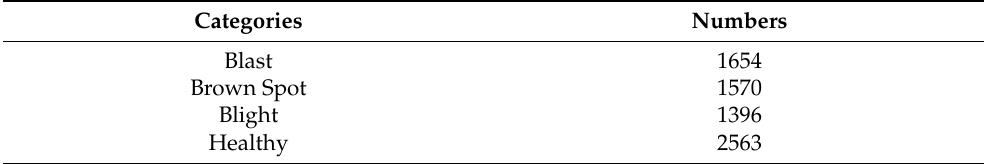
Table 1. Details of the rice leaf disease dataset.